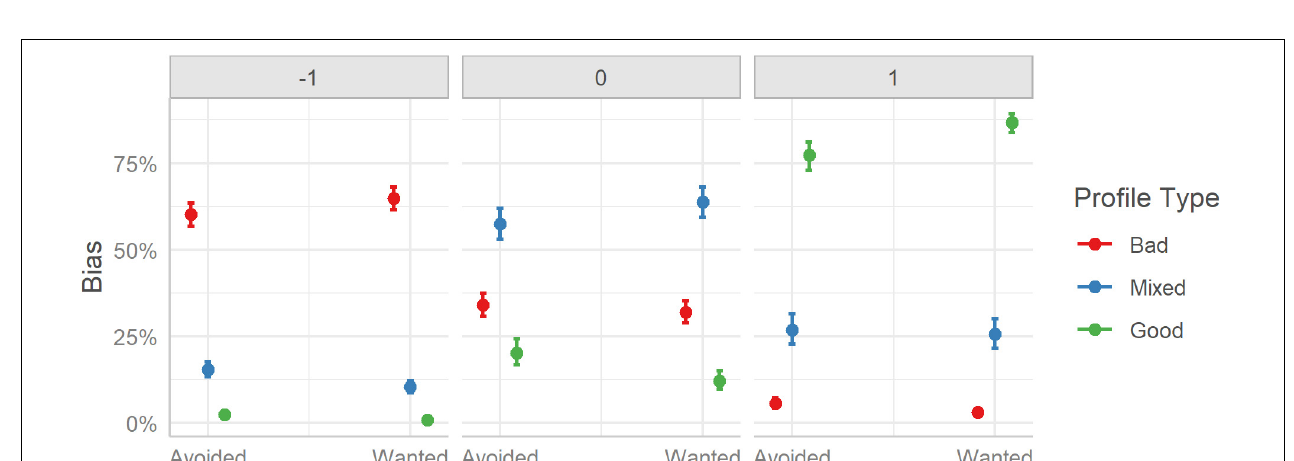
Frontiers in Psychology |